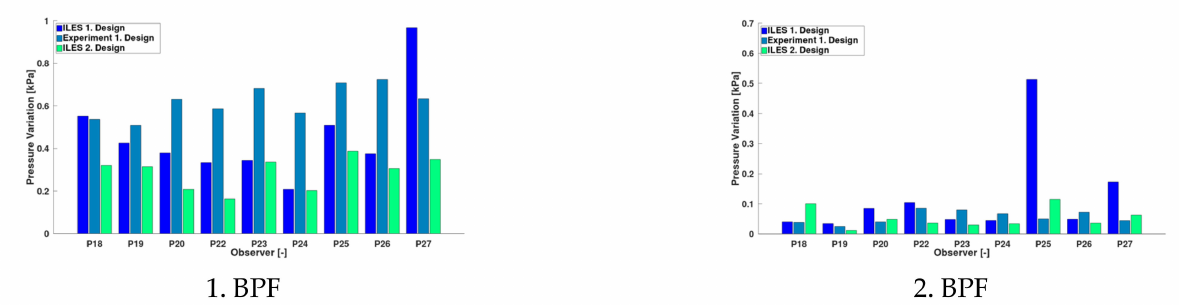
Figure 20. SCHOTTEL reference case 2. Pressure amplitudes at multiples of the blade passing frequency (BPF) in comparison to the experiment and a revised propeller design with model propeller and ship hull and the results scaled to full